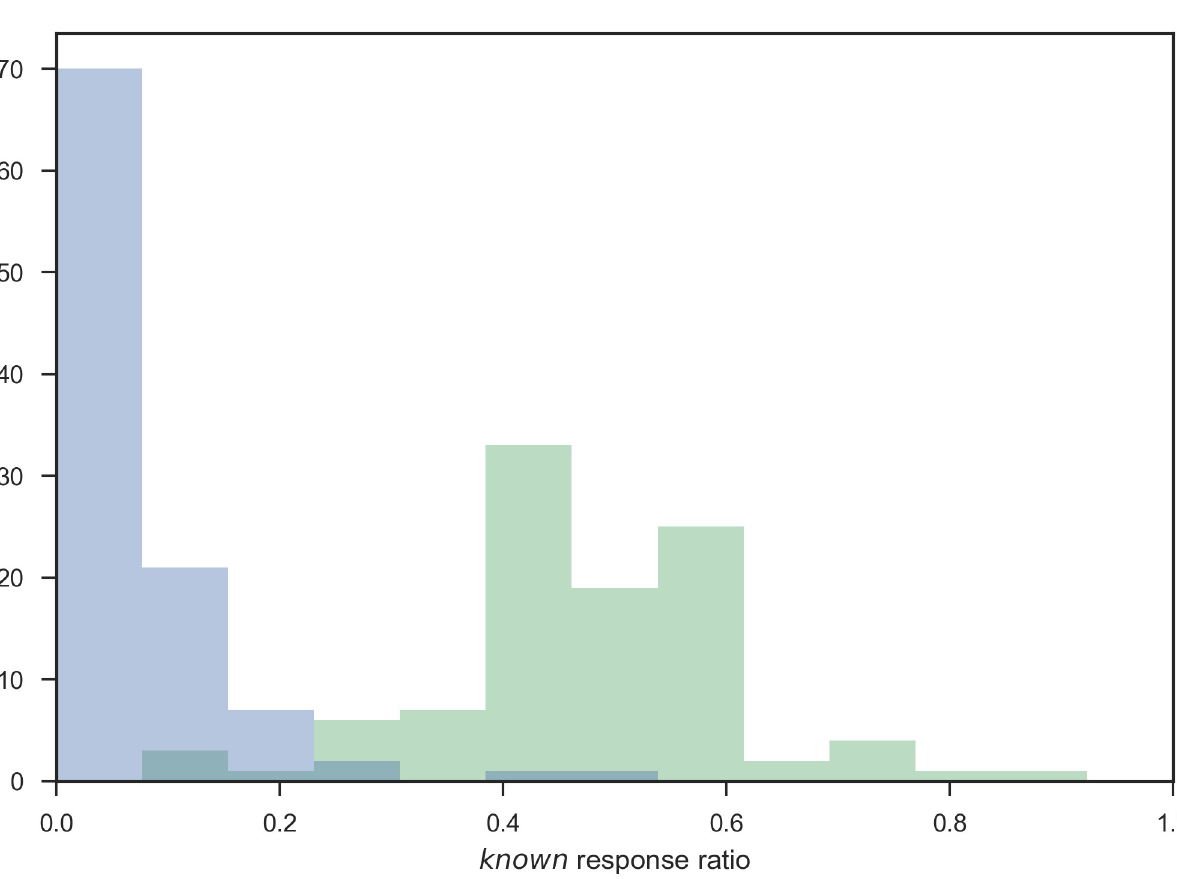
Fig 9. Distributions of f h ( known disease ratio: Green) and f na ( known pseudo-disease ratio: Blue) for all physicians. The dark area indicates the intersection of